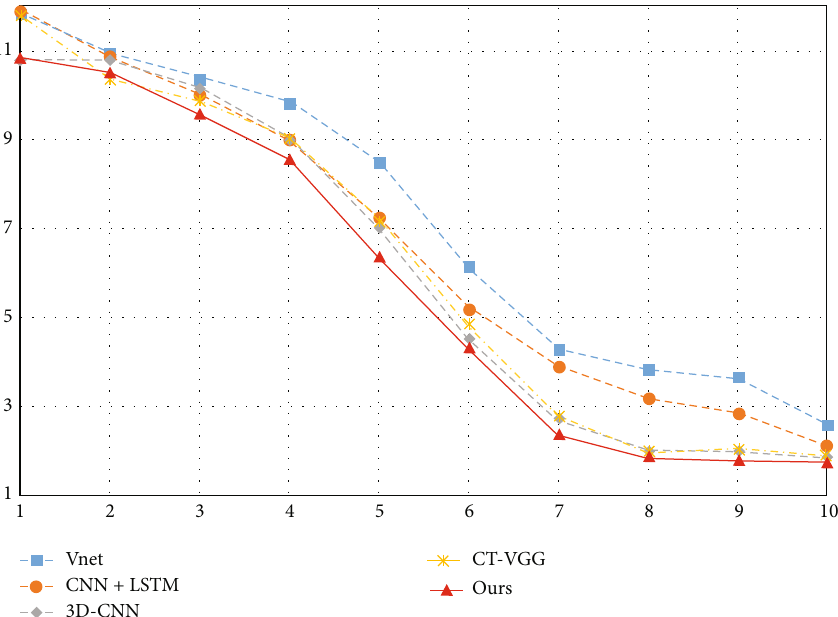
Figure 9: Comparison of false alarm rates of various models with di ff erent time step lengths.